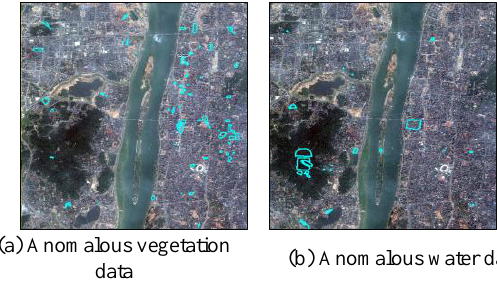
Tab 1. Analysis of the vegetation sample anomaly detection accuracy